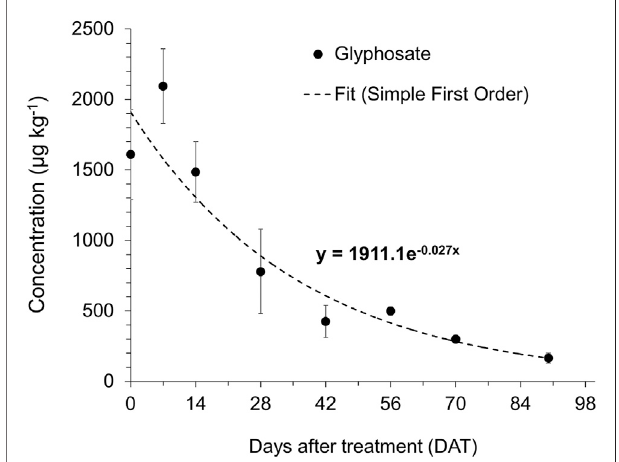
FIGURE3| Fielddissipationkineticsofglyphosate(4.20 kg ae ha − 1 )ina citrusorchard (Location: Immokalee,FL).Error bars,wherevervisible,indicate 95% Con fi dence Interval. The regression equation for the simple fi rst-order kinetic model (C t (cid:1) C 0 e -kt ) is shown.